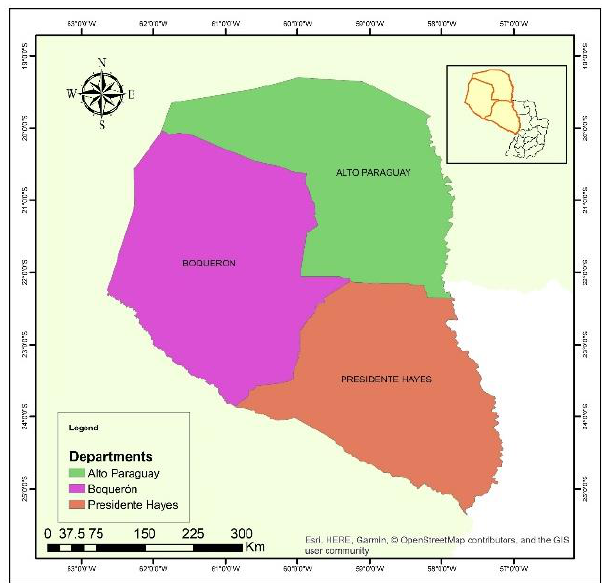
Figure 1. Political Division of the Western Region of